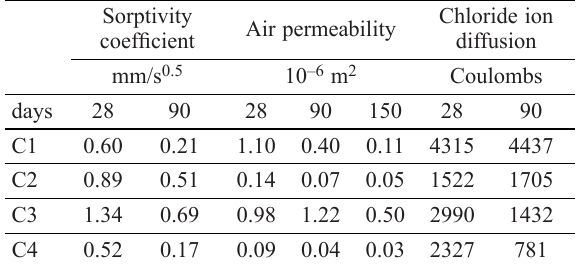
Table 5. Durability properties of mixtures under investigation